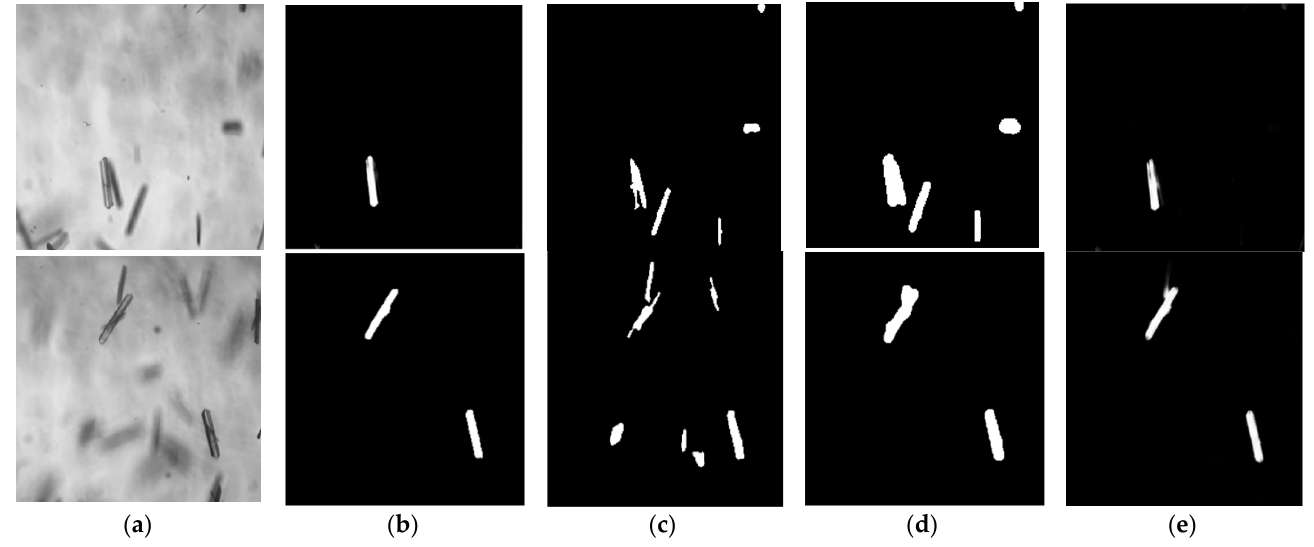
Figure 7. Segmentation comparison results of two LGA images: ( a ) captured images; ( b ) improved segmentation results; ( c ) threshold segmentation results; ( d ) edge detection results; ( e ) original U ‐ net results.